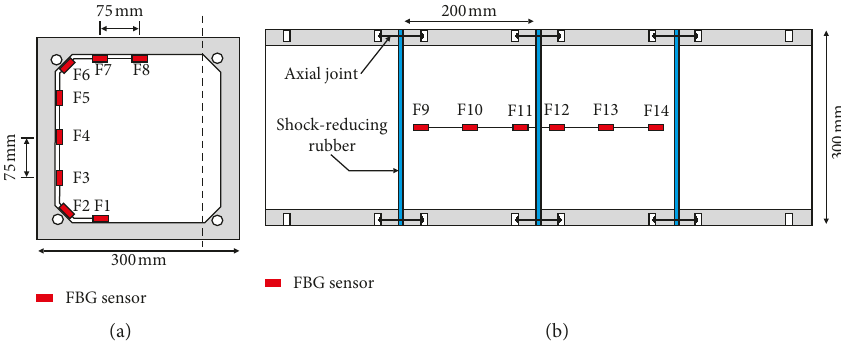
Figure 6: Arrangement of the FBG sensors: (a) cross-section arrangement; (b) longitudinal arrangement.